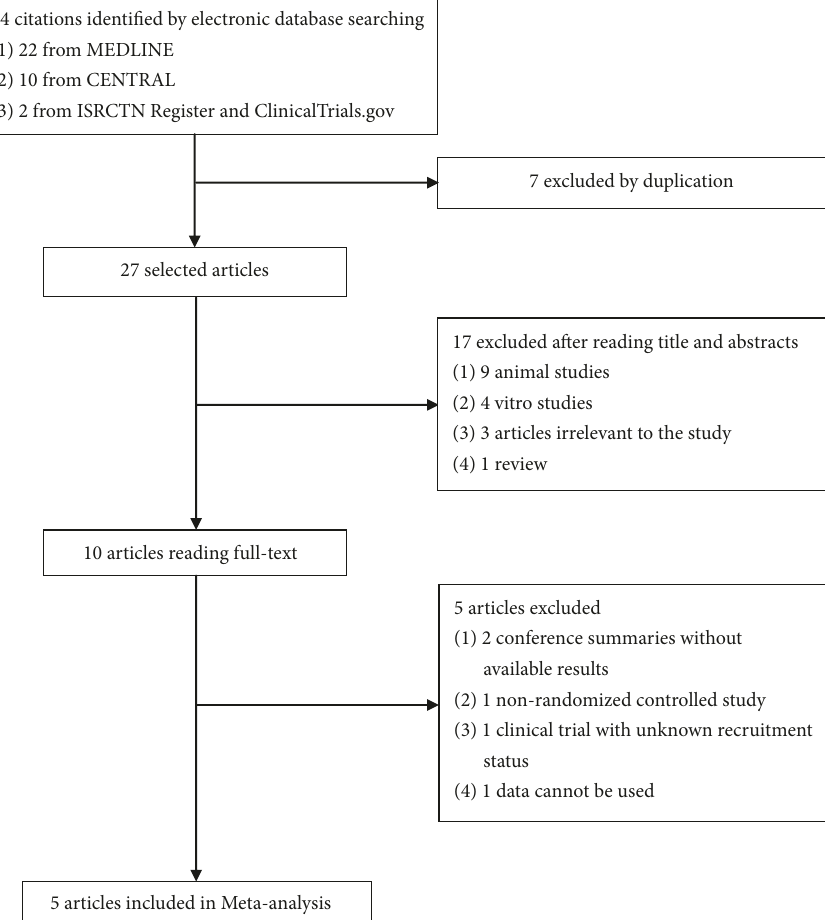
Figure 1: Flow diagram of literature screening and selection